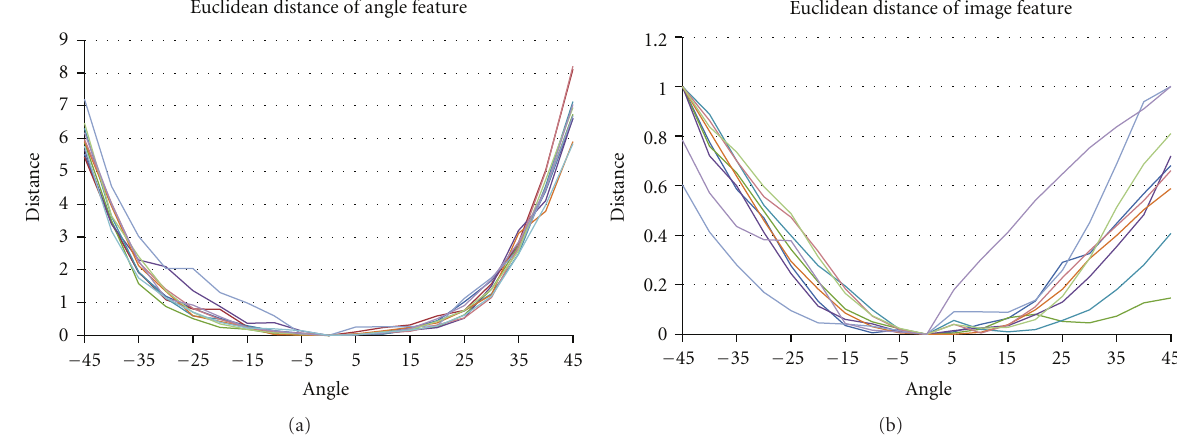
Figure 4: Euclidean distance of (a) angle feature and (b) image feature.